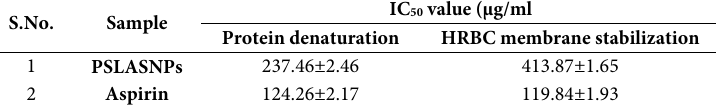
value of PSLASNPs sample 50